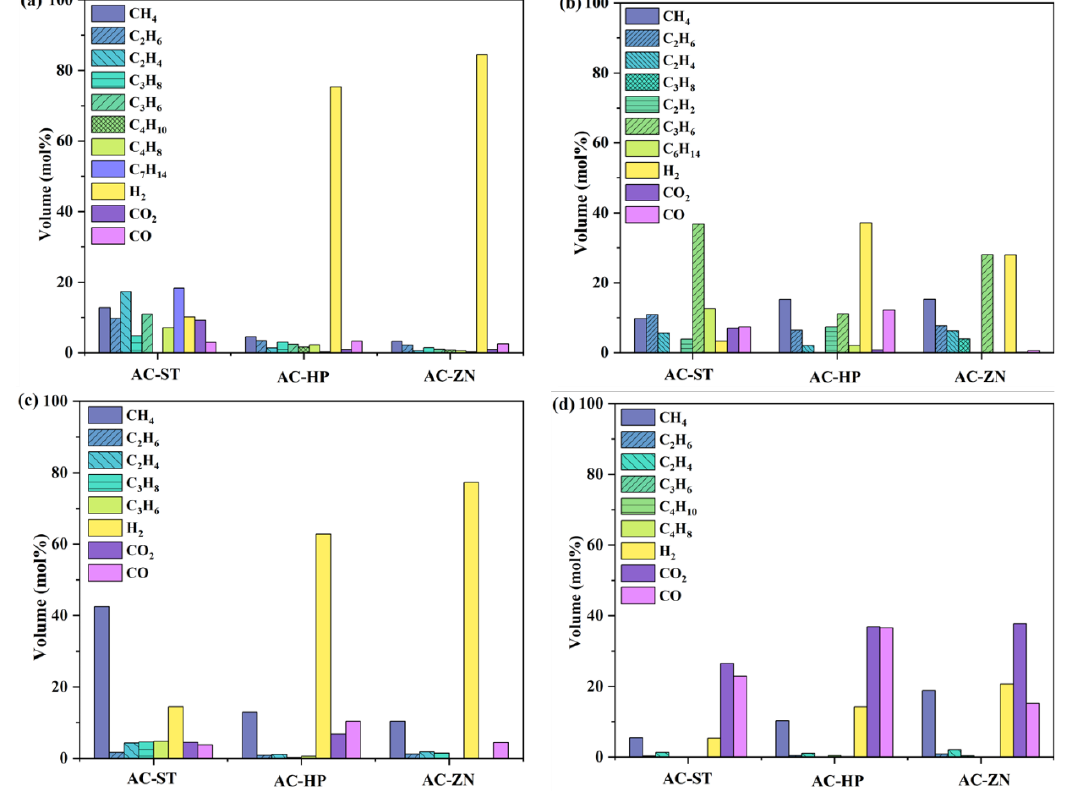
Figure 5. Components of the gas products are catalyzed by carbon modified by steam, H 3 PO 4 , and ZnCl 2 . ( a ) LDPE, ( b ) PP, ( c ) PS, ( d )